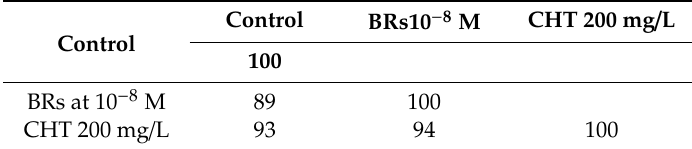
Table 8. Similarity matrix based on analysis of SRAP analysis of control and two treatments of Solidago canadensis cv. Tara plant.